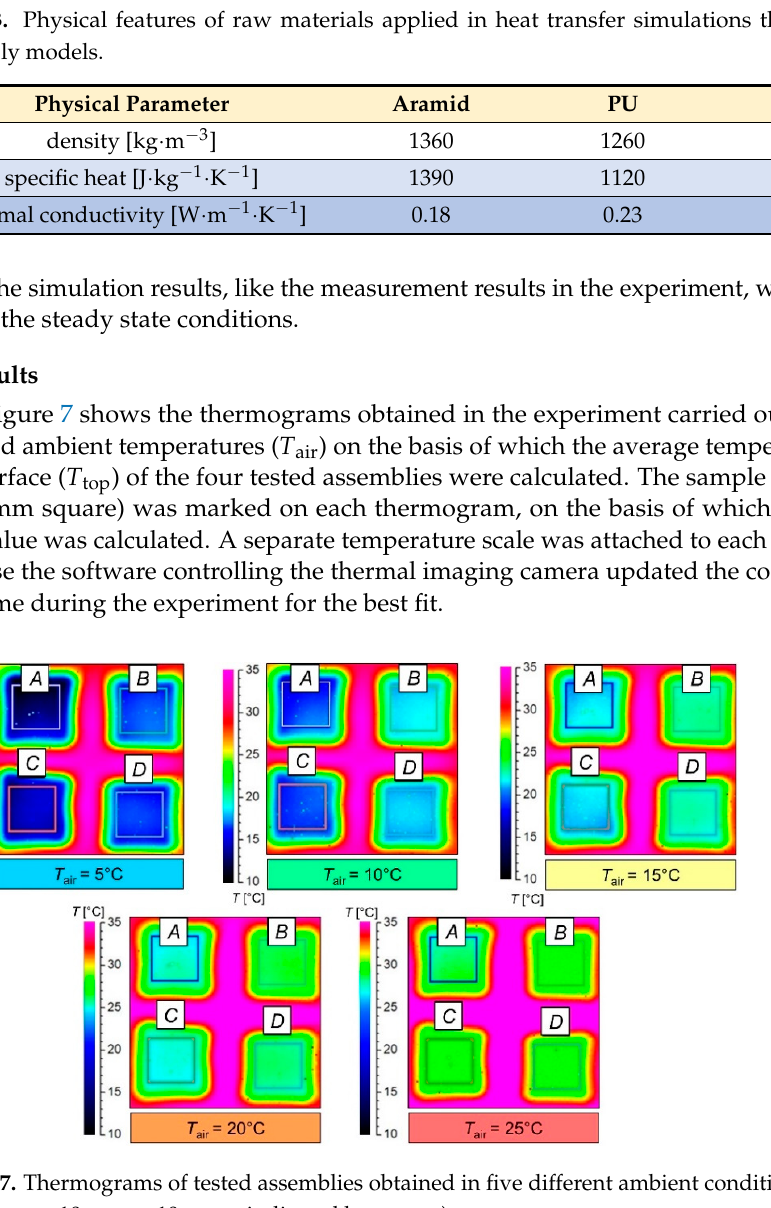
Figure 8. Simulated temperature distributions on 3D models of tested assemblies (surface area: 10 mm × 10 mm). On the outer vertical walls of all 4 assembly models, a vertical linear temperature drop (from hot plate to the surroundings) is visible, which confirms the correct application